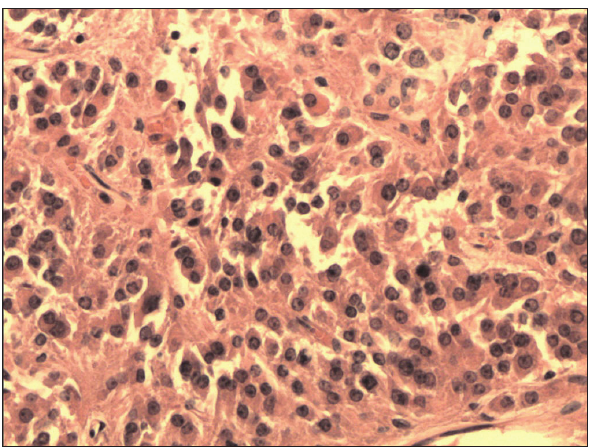
Fig. 3. Leydig cell tumor presents the sharply delimited solid nodul embedded within the ovary. Hematoxylin-eosin,